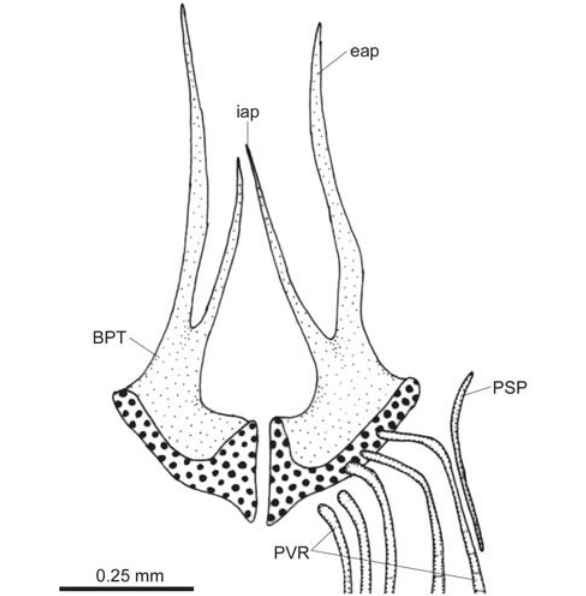
Fig. 8. Pelvic girdle of Ituglanis macunaima , paratype, LIRP 5642 (29.1 mm SL), ventral view, right pelvic rays and splint not shown. Abbreviations: BPT, basipterygium; eap, external anterior process; iap, internal anterior process; PSP, pelvic splint; PVR, pelvic rays.